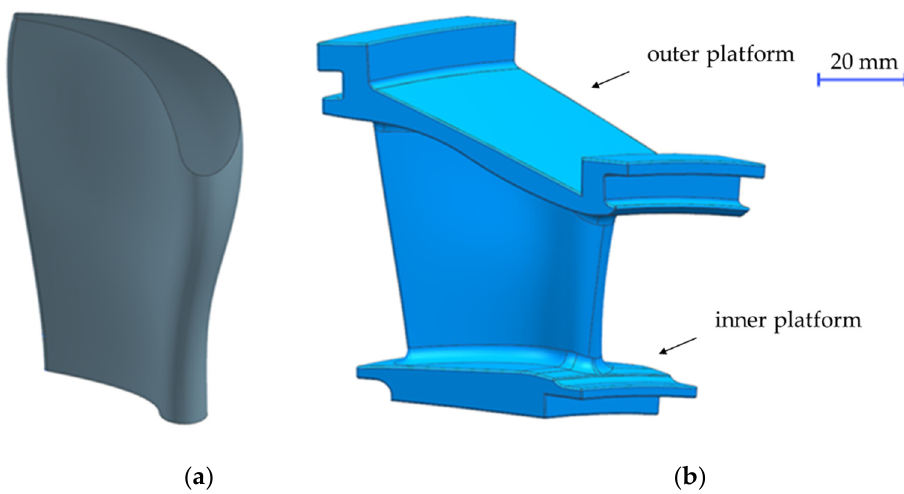
Figure 1. ( a ) 3D airfoil and ( b ) turbine guide vane